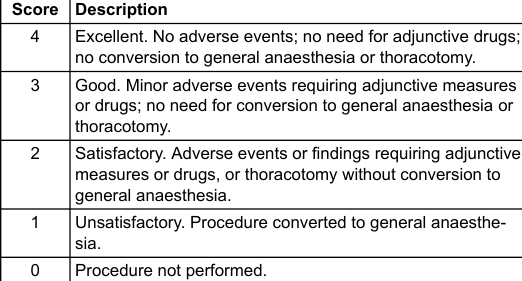
Table 1: Feasibility Score for NiVATS procedures.